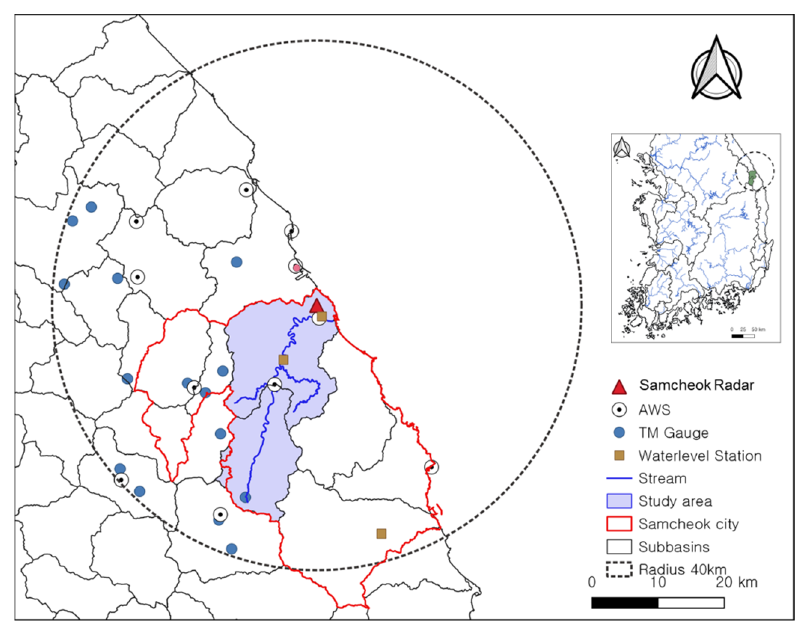
Figure 2. X-band dual-polarization radar location and hydrological observation network in the Samcheok region.